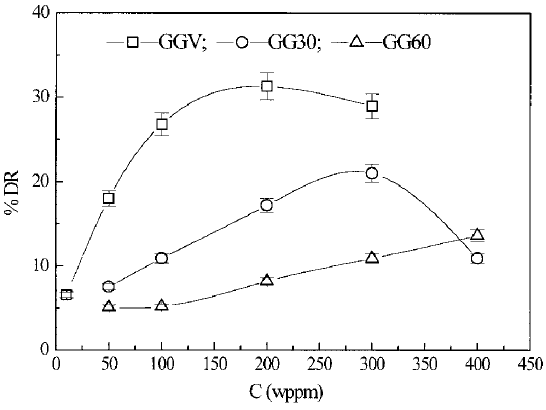
Figure 5. % DR versus the GG concentration for three different molecular weights, reprinted with